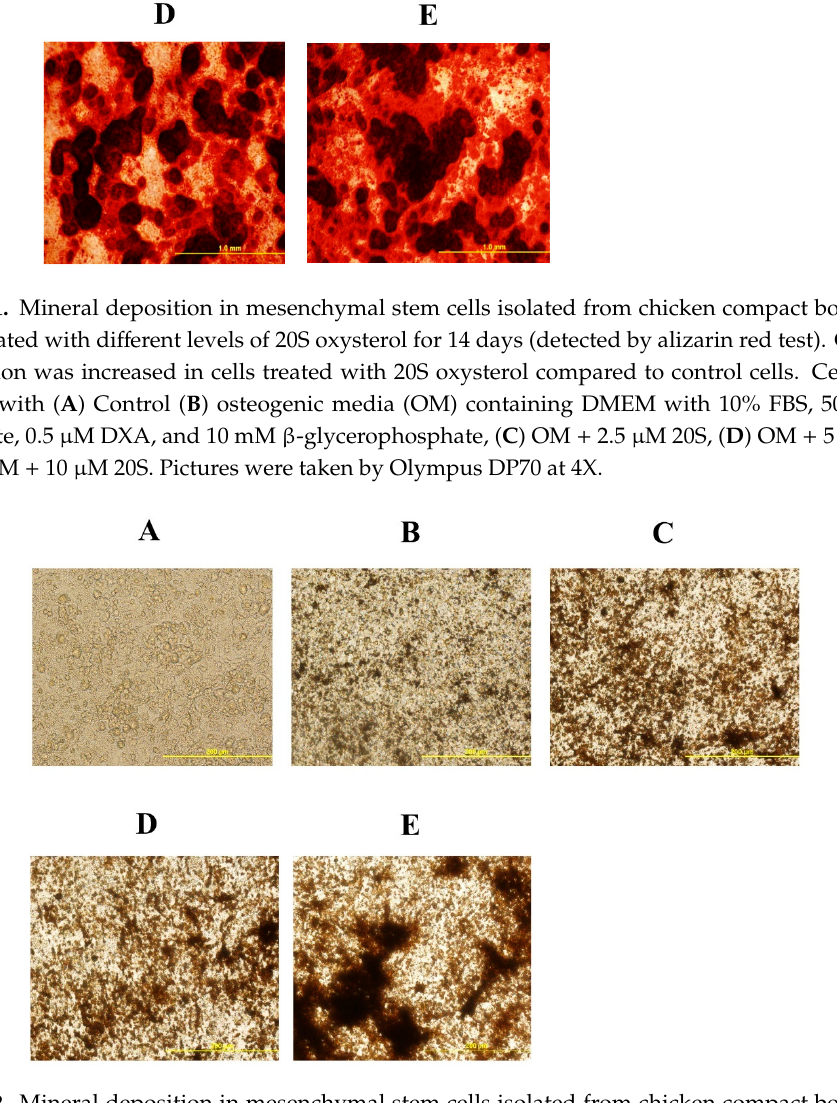
Figure 2. Mineral deposition in mesenchymal stem cells isolated from chicken compact bone stem cells treated with di ff erent levels of 20S oxysterol for 14 days (detected by Von Kossa stain). Calcium deposition was increased in cells treated with 20S oxysterol compared to control cells. Cells were treated with ( A ) Control, ( B ) osteogenic media (OM) containing DMEM with 10% FBS, 50 µ g / mL ascorbate, 0.5 µ M DXA, and 10 mM β -glycerophosphate, ( C ) OM + 2.5 µ M 20S, ( D ) OM + 5 µ M 20S, or ( E ) OM + 10 µ M 20S. Pictures were taken by Olympus DP70 at 20X.